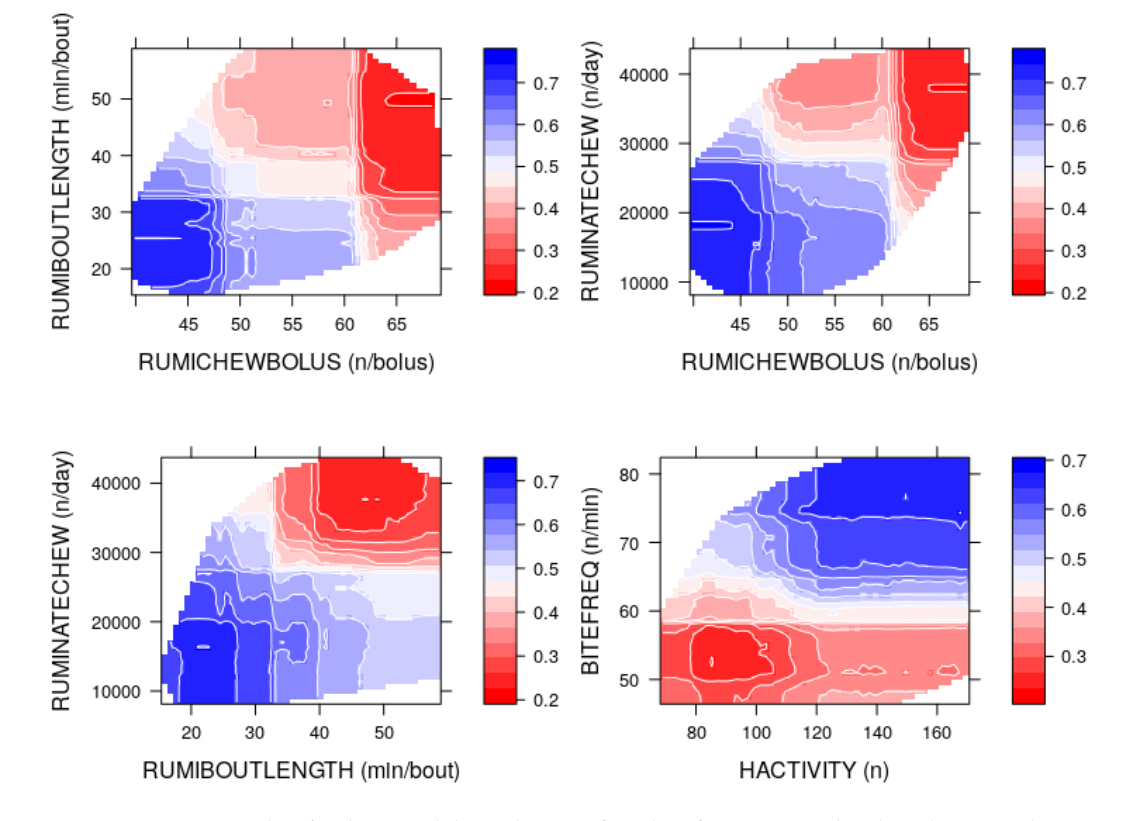
Figure 5. Contour plots for the partial dependencies of random forest on correlated predictors: Colour intensity represents the estimated probability of insufficient allowance versus the recorded predictors in the combined